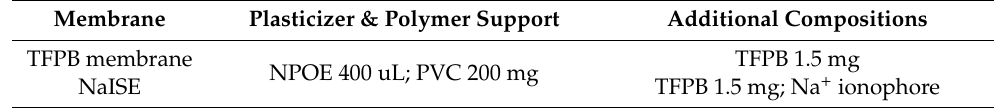
Table 4. The composition of the TFPB membrane and the